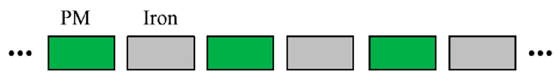
Figure 21. Configuration of PM–iron structure [54].